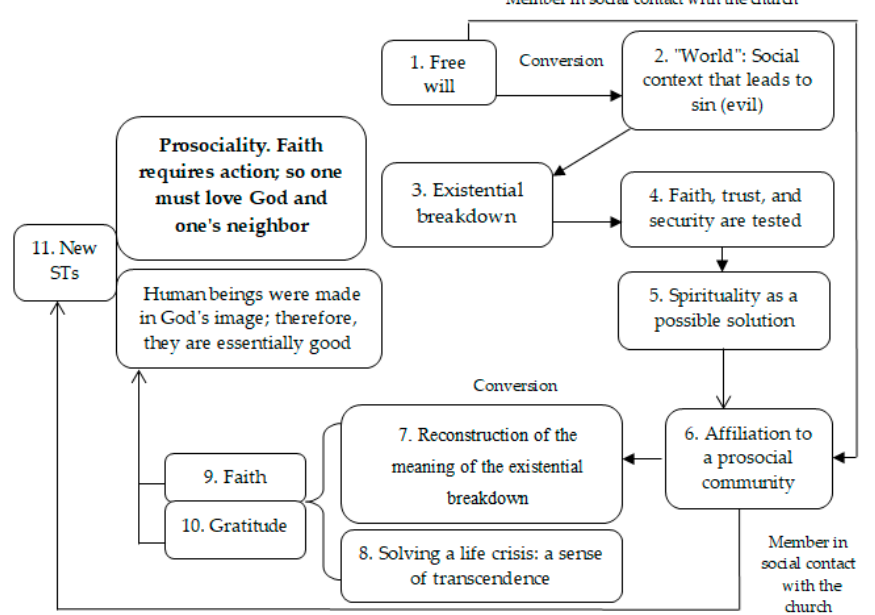
Figure 3. Axial coding: development of prosociality.